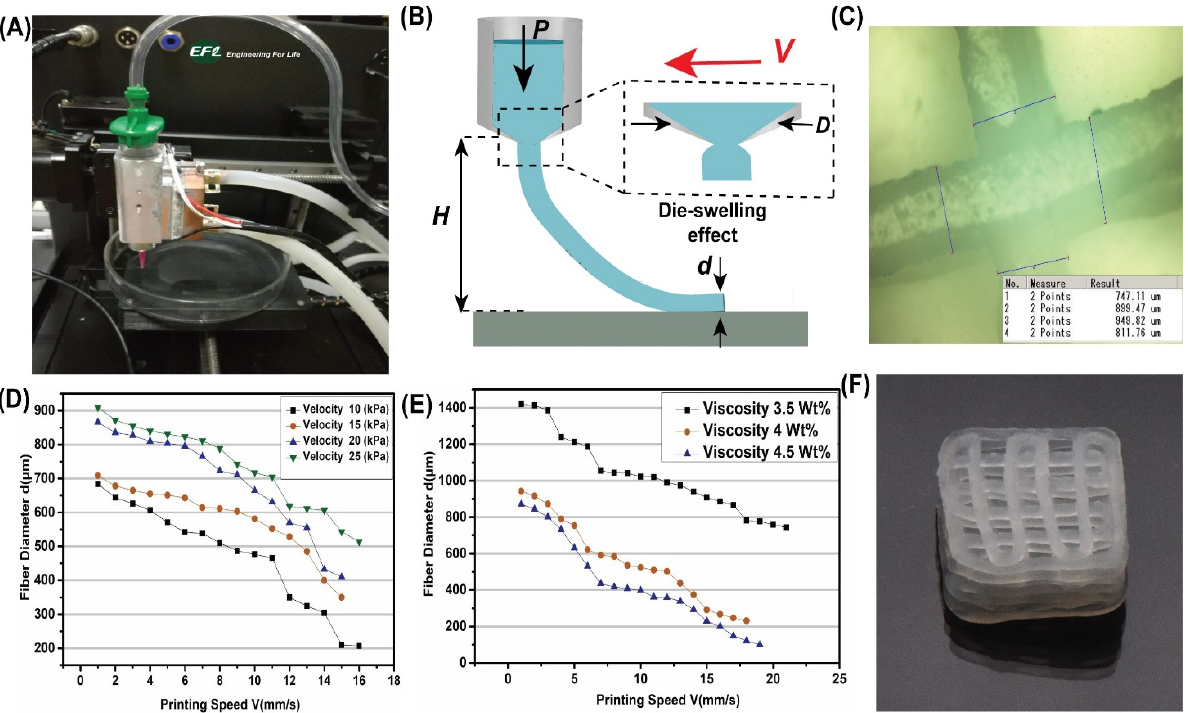
Figure 10. ( A ) Schematic illustration of chitosan hydrogel. ( B ) Typical setup for printing chitosan hydrogels. ( C ) Schematic of measuring fiber diameters. ( D ) Effect of the velocity on the printed fiber diameter. ( E ) Effect of the viscosity v on the fiber diameter d. ( F ) Optical image of a printed scaffold Scale bar: 2 mm.